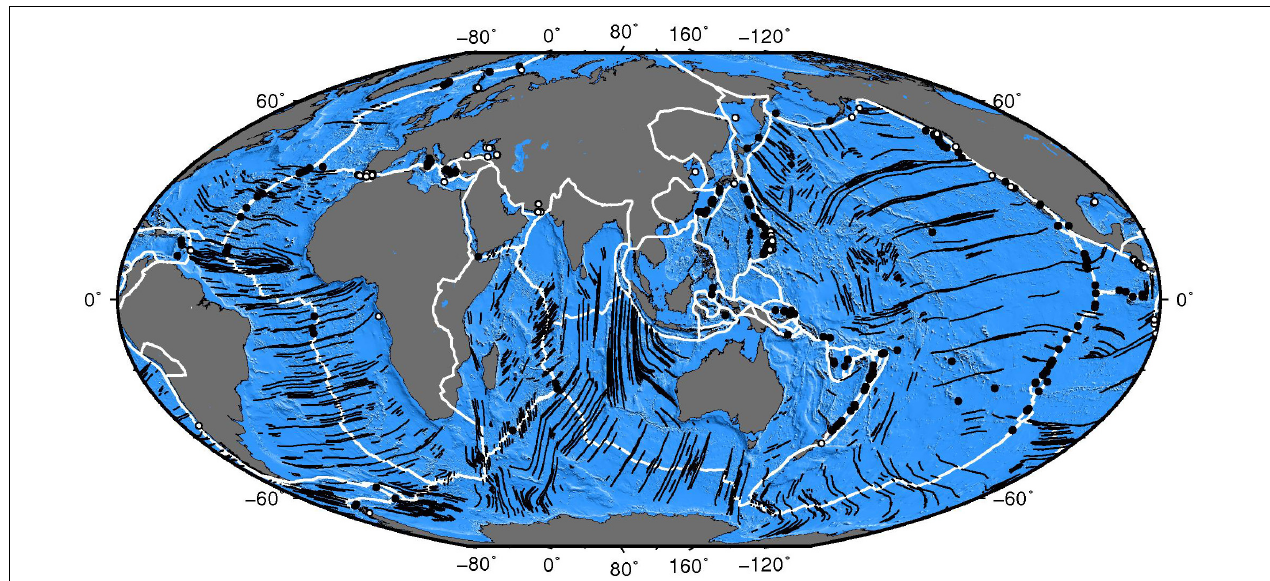
FIGURE 2 | Global bathymetric map with major plate boundaries highlighting active transform faults and oceanic fracture zones (Bird, 2003; Müller et al., 2008; Wessel et al., 2015). Active sites of seafloor hydrothermal venting (solid black circles; Beaulieu and Szafranski, 2018) as well as low temperature seeps (white circles; Hensen et al., 2018) are